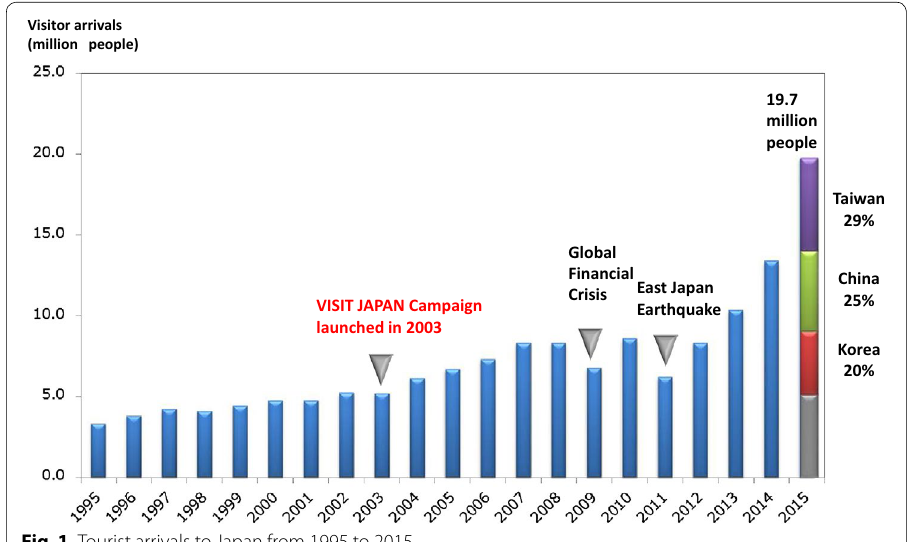
Fig. 1 Tourist arrivals to Japan from 1995 to